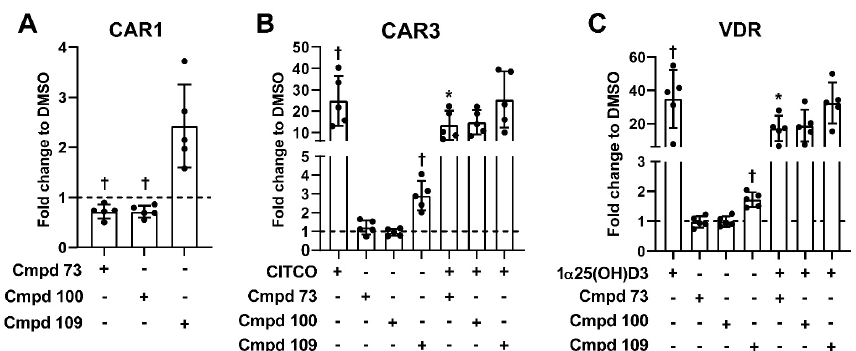
Figure 6. Selectivity of novel PXR ligands within the NR1I group of nuclear receptors. HepG2 cells were transiently transfected with CYP3A4 reporter and expression plasmids encoding ( A ) CAR1 or ( B ) CAR3, or ( C ) direct repeat (DR3) 3 reporter and expression plasmid encoding VDR. Cells were treated with 0.2% DMSO or 10 µM chemicals as indicated. 1 α ,25(OH) 2 D 3 was used at 1 µM. Data are shown as mean ± SD fold induction with respect to DMSO-treated cells from five independent experiments and individual experiments illustrated with dots. Statistically significant differences are illustrated with asterisks and daggers. † p < 0.05 single treatments compared to DMSO-treated cells set as 1 and analyzed by one sample t -test corrected by the method of Bonferroni. * p < 0.05 cotreatments compared to ( B ) CITCO or ( C ) 1 α ,25(OH) 2 D 3 analyzed by repeated measures one-way ANOVA with Dunnett’s multiple comparisons